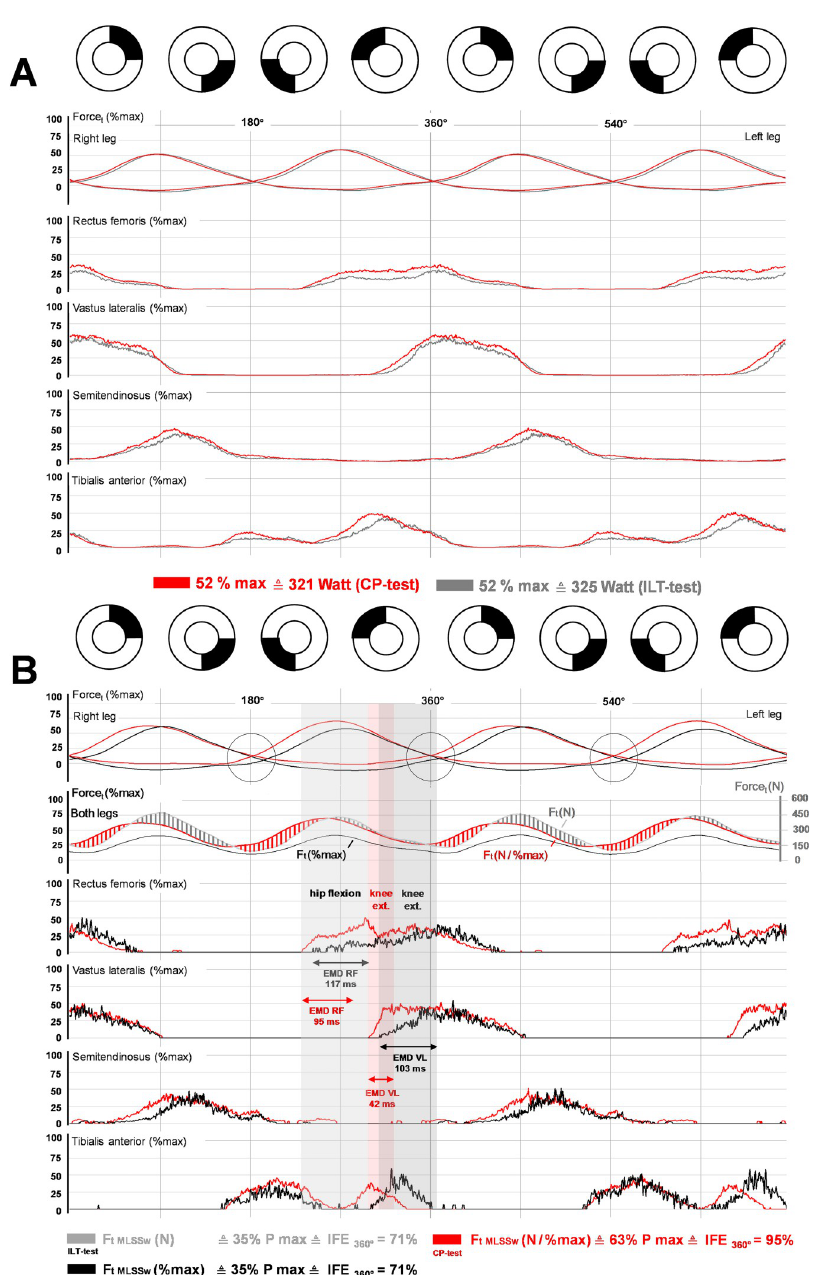
Fig 8. Comparison of CP- and ILT-tests. (A) Average normalized bi-pedal crank force and EMG data across two pedal cycles (0–720˚) at the MLSSw for ILT-tests (black) vs CP-tests (red) (n = 11). Considering the methodological problems of comparing EMG data recorded on different days, activation of the four recorded lower limb muscles appeared to be earlier and more intense in CP-test. (B) Average normalized bi-pedal crank force, total average tangential force and average EMG data for test subject 9 across two pedal cycles (0–720˚) at the MLSSw during ILT- (black) and CP-tests (red) (B, top row) . (B, second line) depicts curves of absolute propulsive force (Newton). Due to the early and strong RF/VL activity during the CP test, the force drops less at TDC and rises more steeply in Q1 than in the ILT-test. Note the different electromechanical delays (EMDs) for RF and VL (for further explanations see Fig 6).